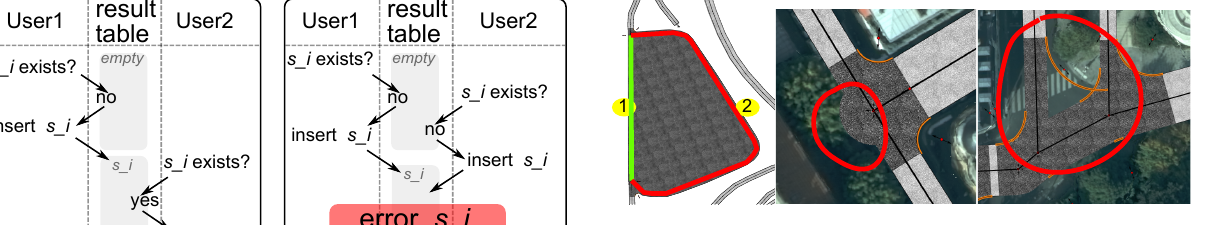
Figure 14: Various cases of failure from more severe to less severe (1 , 2 , 3). 1 : loop, 2 : bad buffer use, 3 : radius too big for network.